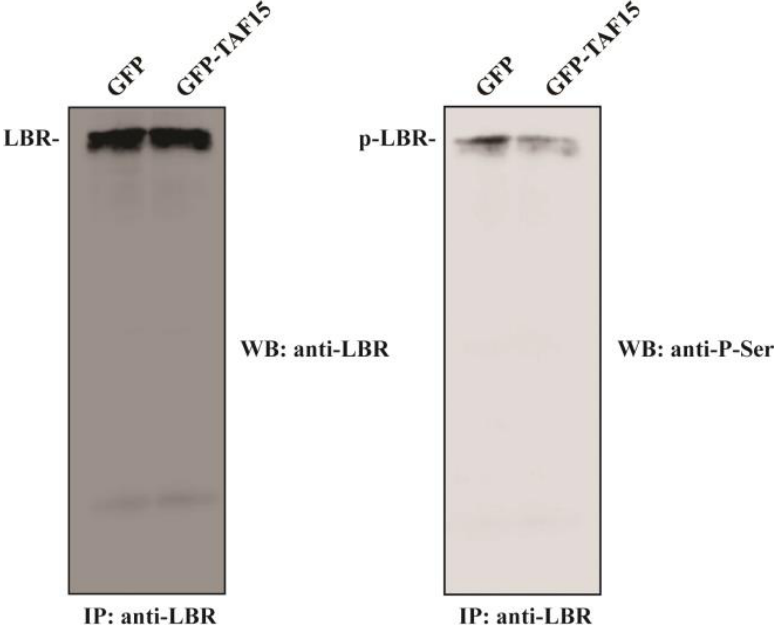
Figure 7. Overexpression of TAF15-RGG results in reduced LBR phosphorylation. HeLa cells were transfected with GFP or GFP-TAF15-RGG. LBR was immunoprecipitated from cell lysates with an anti-LBR monoclonal antibody. Immunoprecipitates were then analyzed by Western blotting using the anti-LBR antibody ( left panel ) and an anti-P-Ser polyclonal antibody ( right panel ).